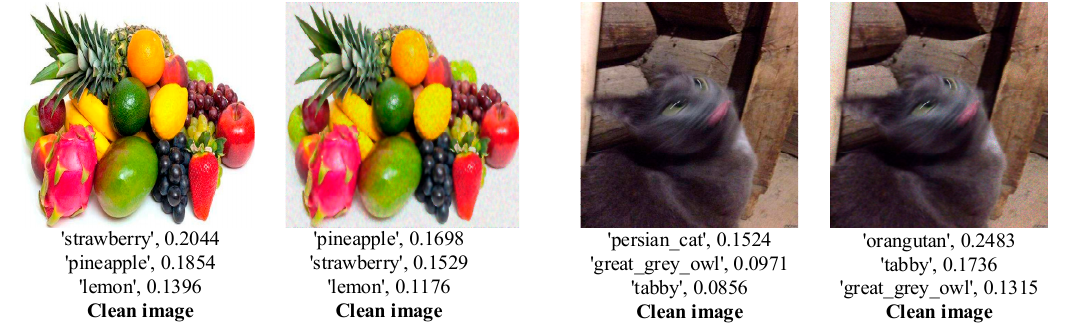
Figure 7. false classification by anomalous image. Figure 7. False classification by anomalous